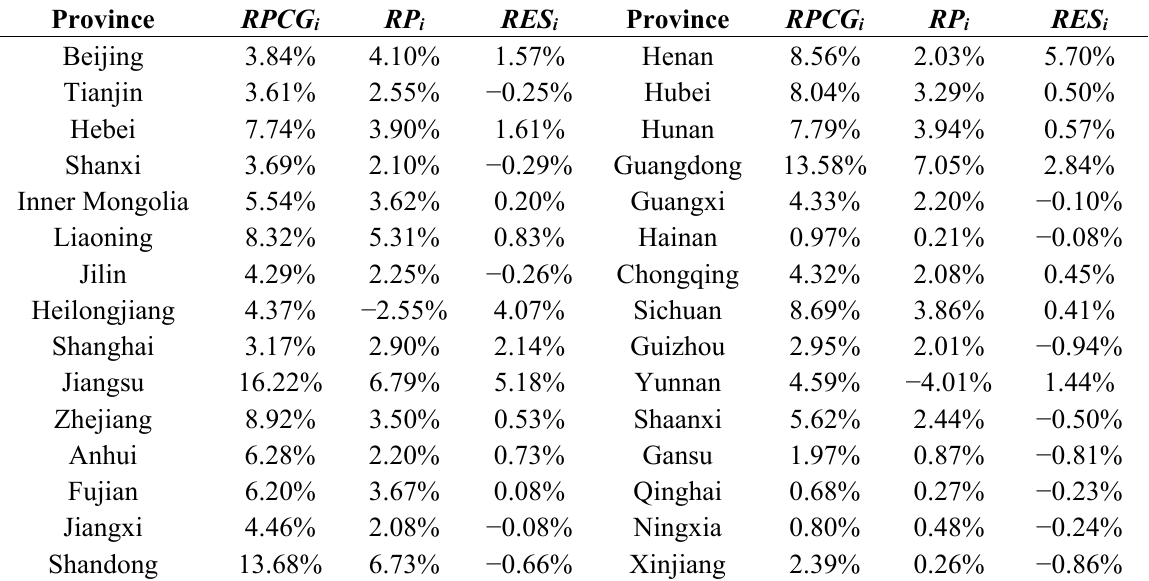
Table 3. Different parts of China’s three kinds of influencing factors of contribution rate.